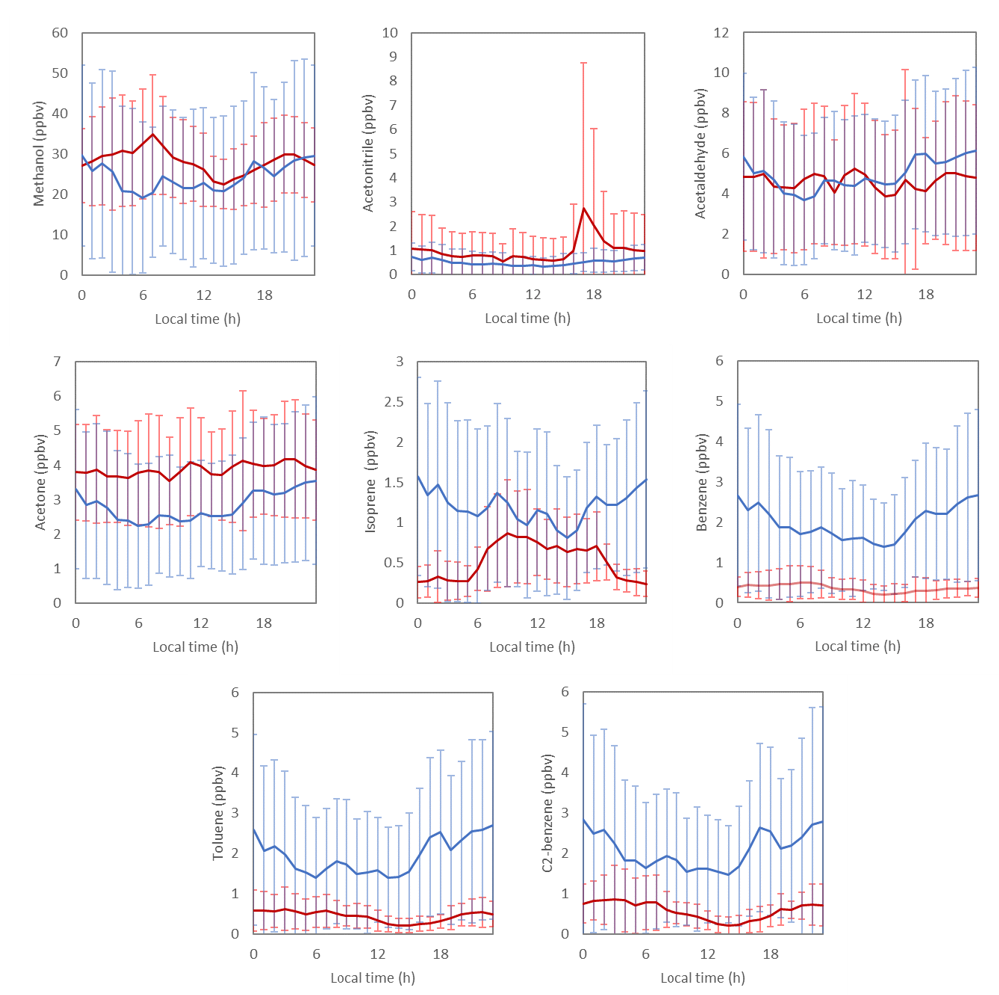
Figure 5. Diurnal profiles of the dominant VOCs observed in Beijing during the APHH-Beijing winter (blue) and summer (red) campaigns (in ppbv). Error bars show the standard deviation across the measurement